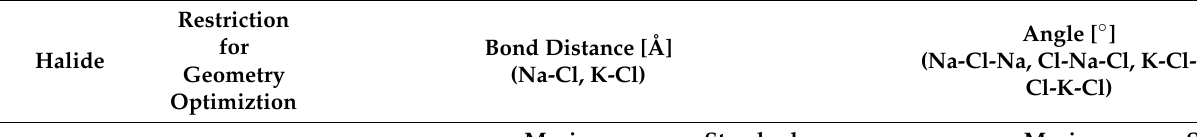
Table 4. Comparison of calculated geometric parameters for NaCl and KCl models of crystal struc- tures (125 atoms) for calculation at the DFT/B3LYP level of theory with 6-31g* basis set.